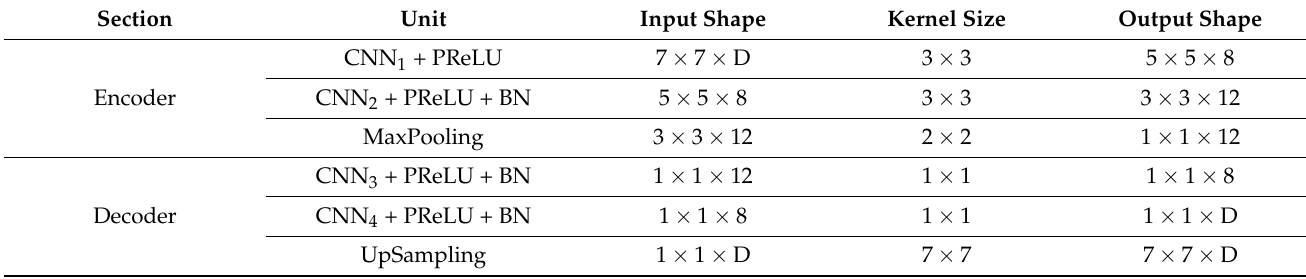
Table 2. The configuration of the proposed CAE for the